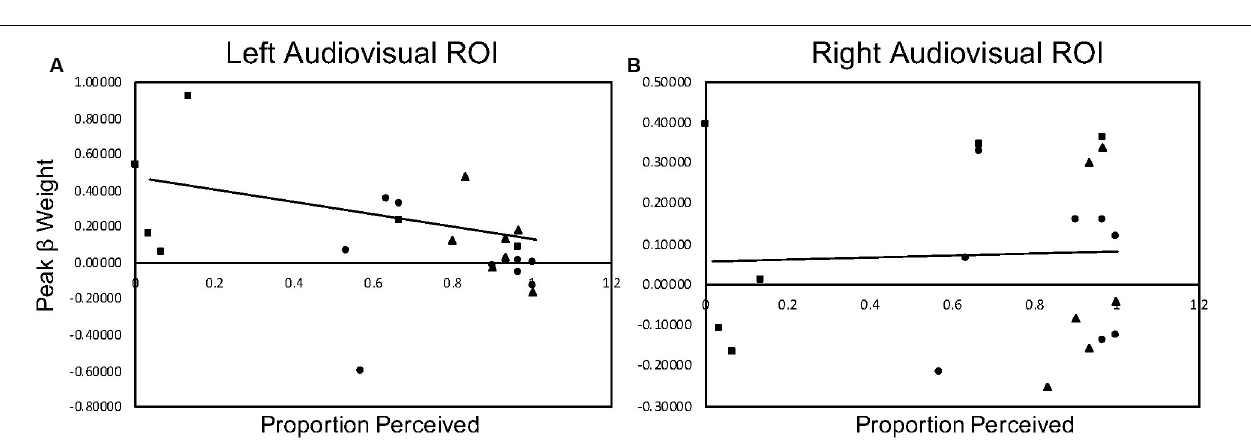
FIGURE 7 | McGurk behavioral performance during scan sessions correlated with peak beta weight activation in the left (column (A) ) and right (column (B) ) audiovisual ROI during McGurk trials. The BV group is represented with a circle marker, the MV group is represented with a triangle marker and the ME group is represented with a square